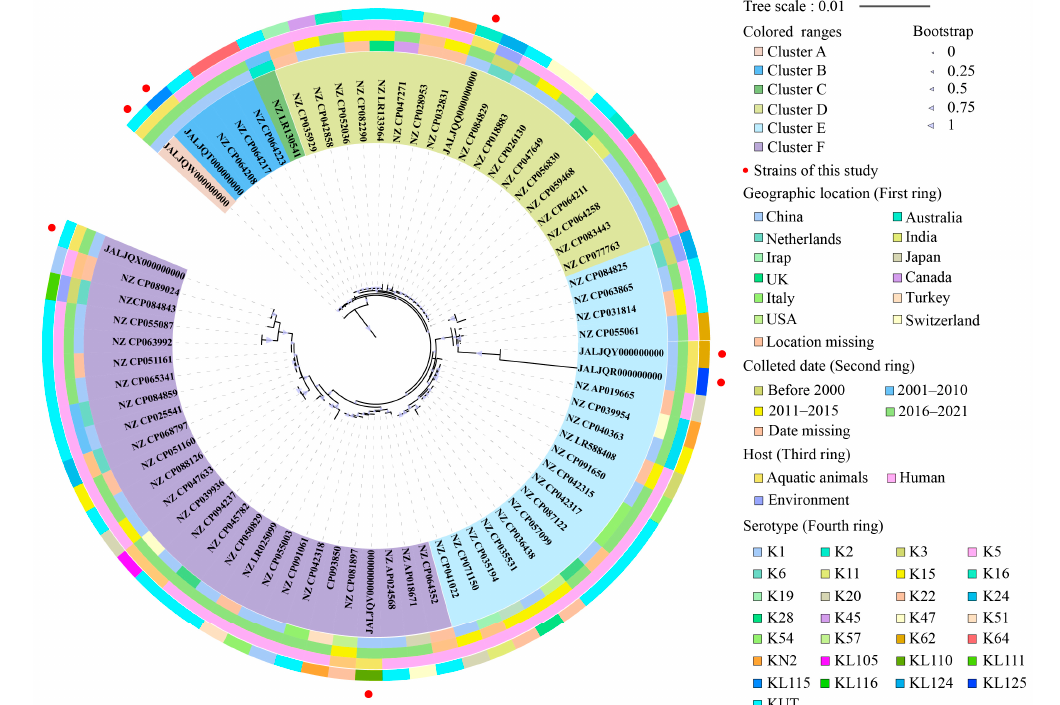
Figure 8. The phylogenetic tree showing the relationship of the 72 K. pneumoniae genomes. Complete genome sequences of the 65 K. pneumoniae isolates were retrieved from the GenBank database with accession numbers shown in the tree. The seven K. pneumoniae genomes determined in this study were marked with red dots. The maximum likelihood method was used to build a tree, with 1000 bootstrap replications and a cut-o ff threshold of ≥ 50% bootstrap values.